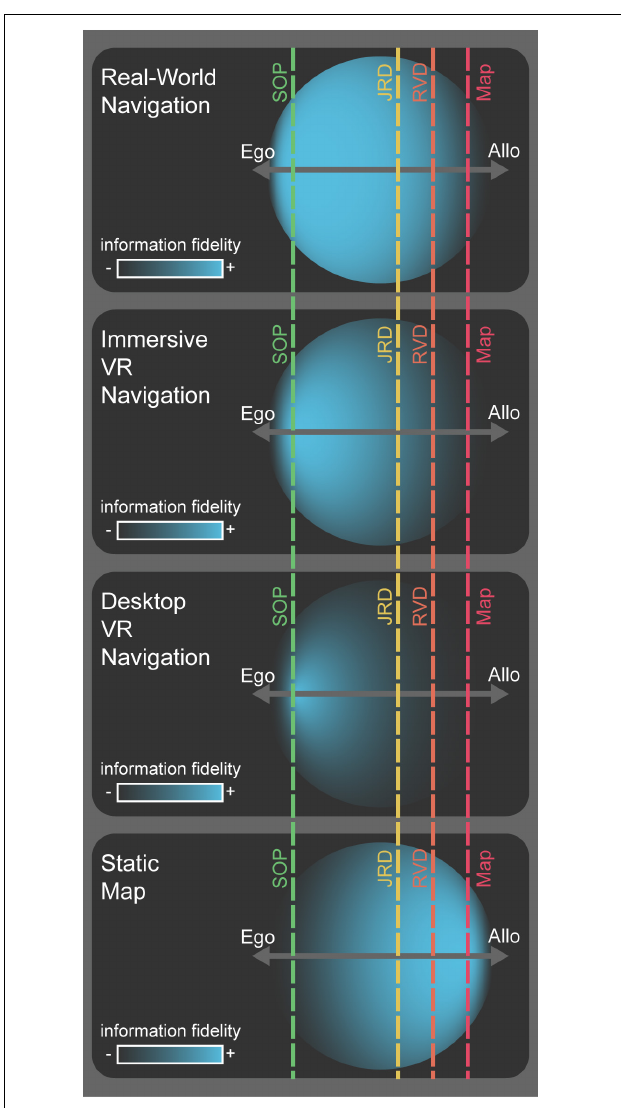
FIGURE 2 | Conceptual model for the encoding and deployment of spatial information. Hypothetical spatial information (blue circles) acquired during early encoding of a novel environment via various encoding modalities (labels, left). Each example shows the fidelity of spatial information acquired (density and center of mass for blue circles) along an egocentric-to-allocentric continuum (dark gray, horizontal axes). The extent to which the circles project outward from the egocentric-allocentric axis illustrates information that, while not strictly spatial in nature (e.g., semantic or episodic memory), can be used to derive spatial information or drive inferences about the environment. The offset of the vertical, dashed, lines from the center of the egocentric- allocentric axis represents the hypothetical proportion to which that task depends more on egocentric or allocentric reference frames for its optimal solution (SOP: green, JRD: yellow, RVD: orange, map drawing: red).